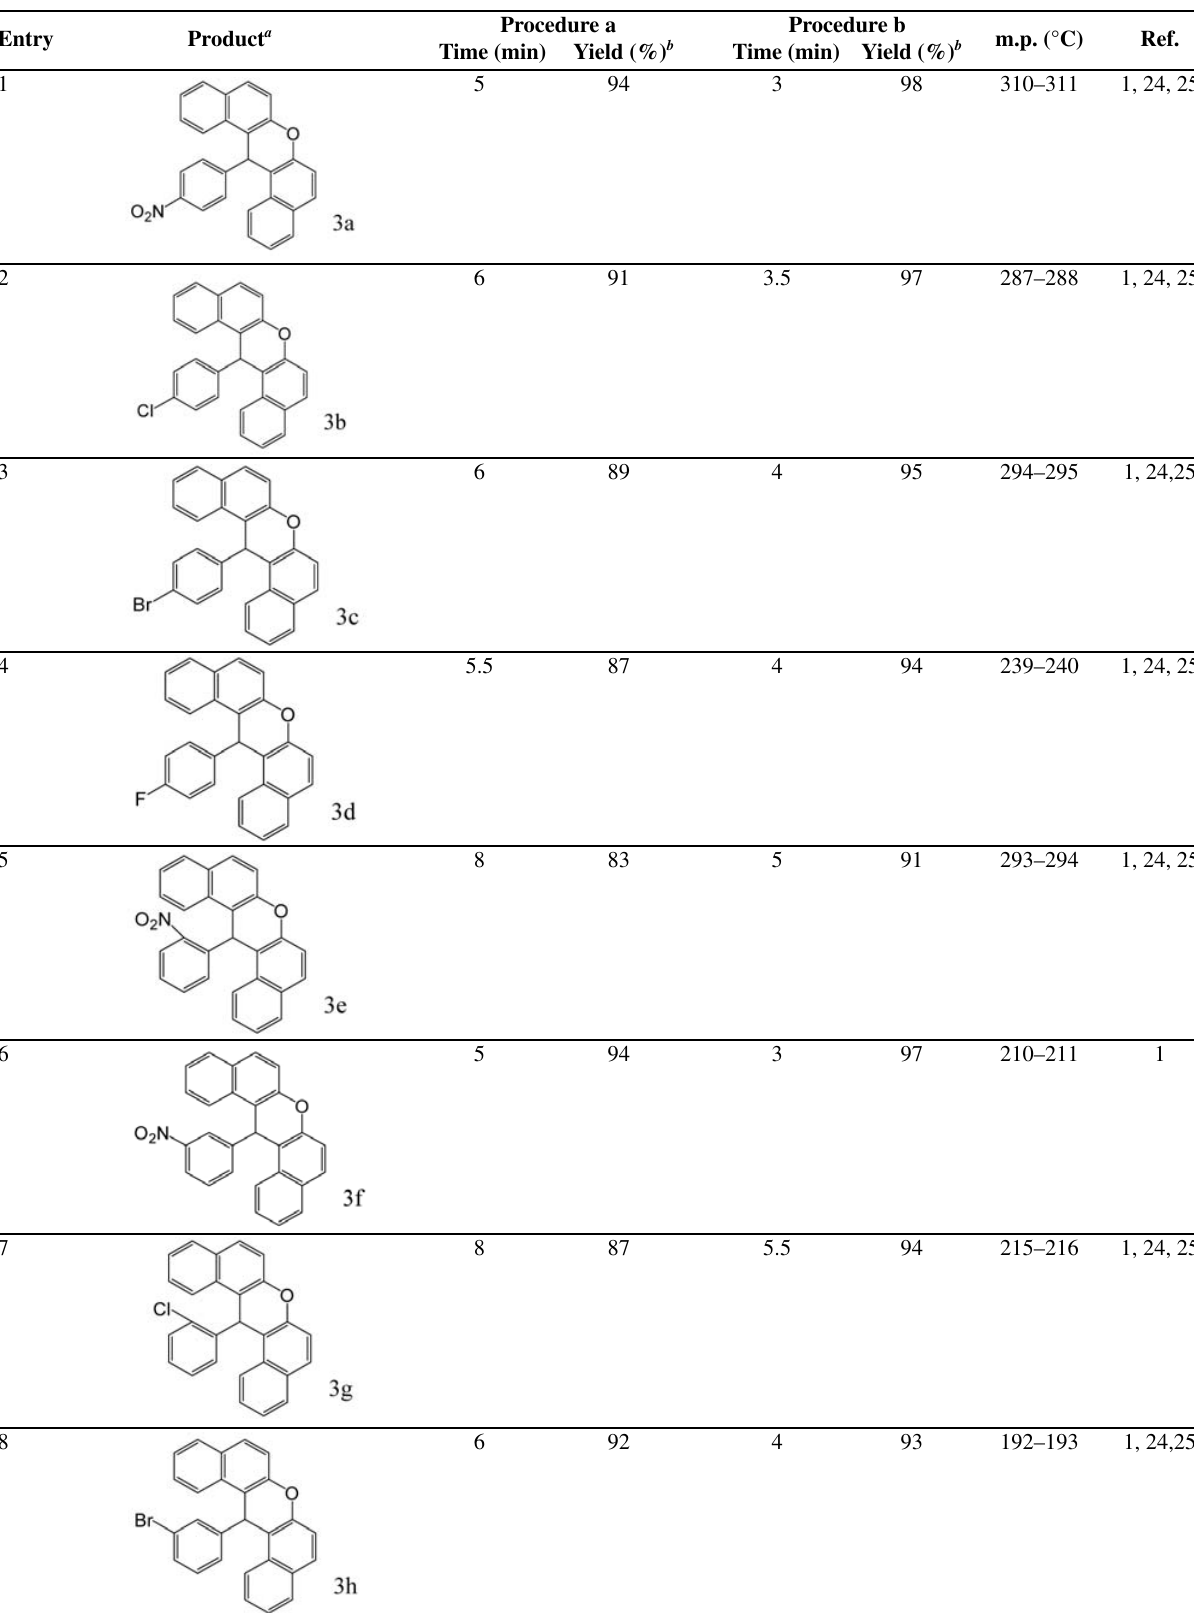
Table 2 . Synthesis of 14-aryl-14 H -dibenzo [ a,j ] xanthenes and comparison of efficiency of [ DABCO ]